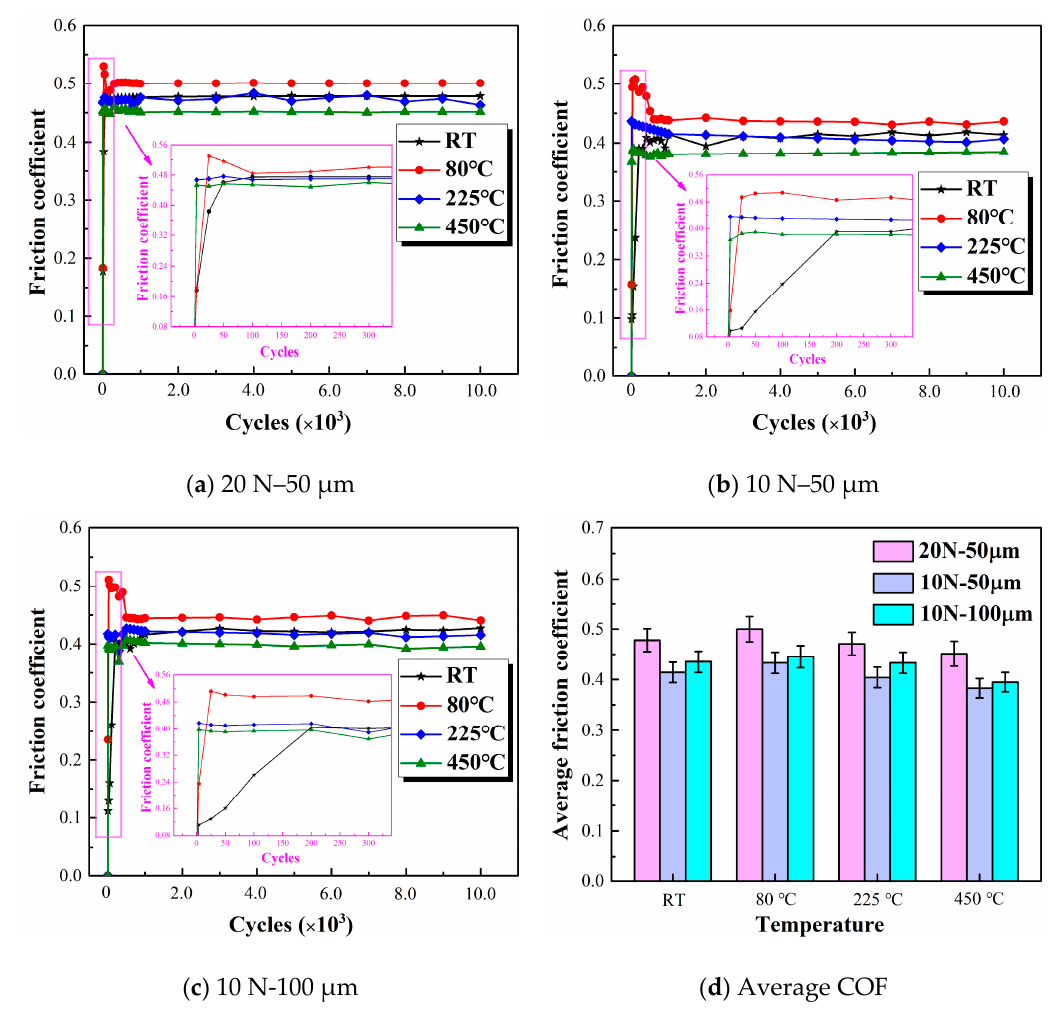
Figure 2. Evolution of COF with the number of cycles at varied temperatures.